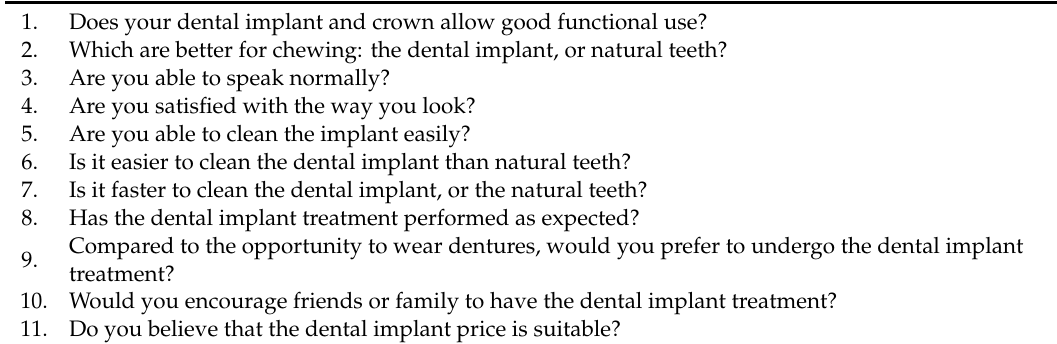
Table 2. Questionnaire for evaluating patient